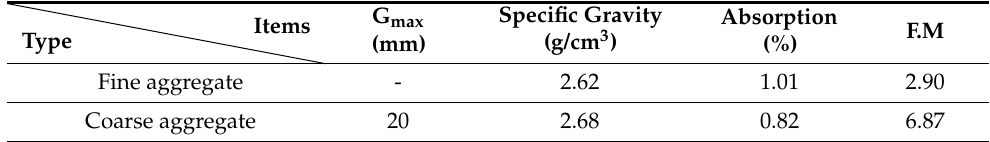
Table 3. Physical properties of fine and coarse aggregates.